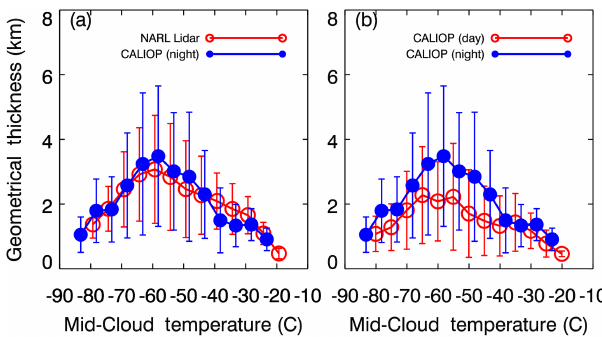
Figure 9. Dependence of geometrical thickness of cirrus cloud lay- ers on mid-cloud temperature obtained from (a) NARL Lidar (open red circles) and CALIOP night-time (filled blue circles) data, (b) CALIOP daytime (open red circles) and CALIOP night-time (filled blue circles) data. Circles show the average value while the error bars show the standard